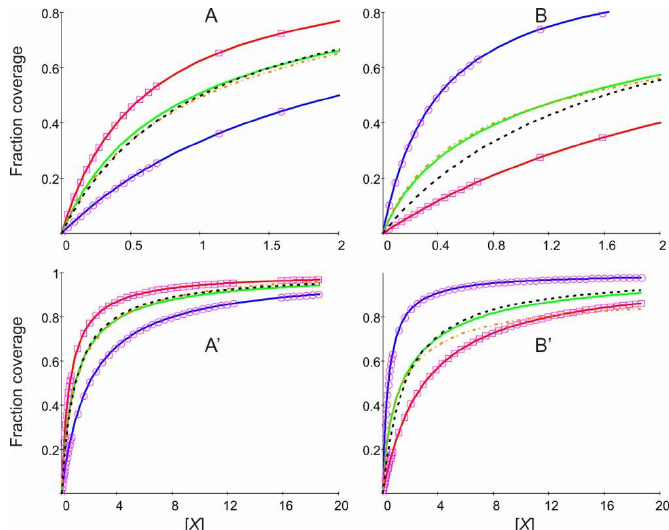
Figure A2. Isotherms expressed as a function of the concentration of [ X ]. ( A’ ) calculated for K 1 = 5.0 and K 10 = 1.0; ( B’ ) calculated for K 1 = 1.0 and K 10 = 5.0. ( A , B ) in the range of X between 0 and 2 and ( A’ , B’ ) between 0 to 6. Solid lines: Amount of the objects X m { AB } X n . Red: m = 1,2,3, all n ; divided by 3. Blue: { AB } X n , n = 1,2; divided by 2. The rectangles and the circles correspond to Langmuir’s eqs. (29) and (29A) of ref. [1] with K L = K 1 / 3 and K L = K 10 / 2, respectively. Green: all X m { AB } X n , except { AB }, divided by 5. Black, dashed: Isotherm calculated using Langmuir’s eqs. (29) and (29A) of ref. [1] with optimized values for K L . Orange, dash dot: Sum of the red and the blue curves weighted by an optimized